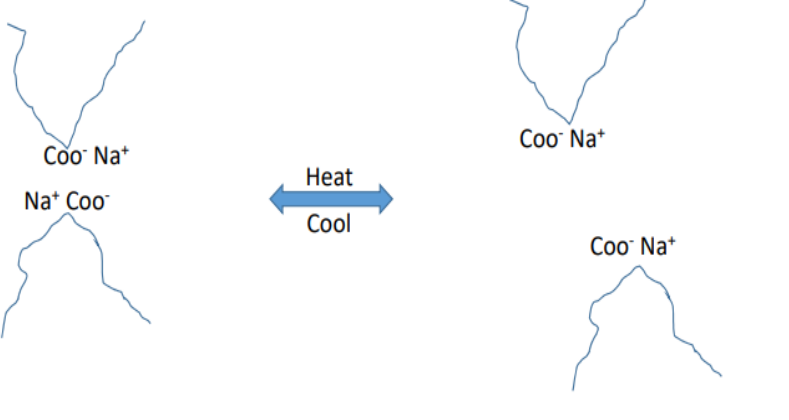
Figure 7. Reversible iconic interactions [6].